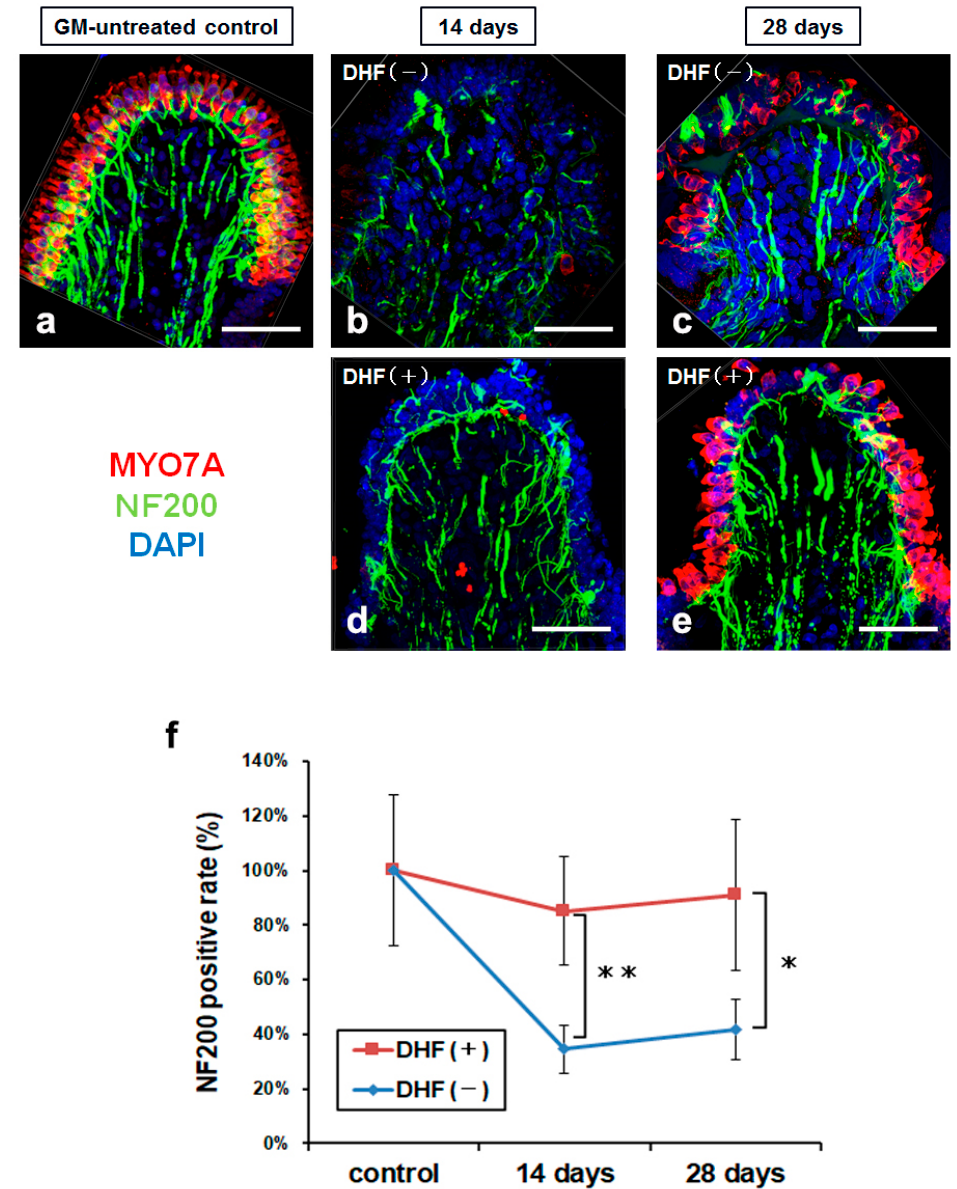
Figure 4. Protection of nerve fiber. ( a – e ) Three-dimensional images of the crista ampullaris stained with MYO7A antibody (red), NF200 antibody (green), and DAPI (blue). ( a ) GM-untreated control. ( b , c ) The cristae without DHF at 14 and 28 days after GM injection. ( d , e ) The cristae with DHF at 14 and 28 days after GM injection. The ampullary nerves of the DHF (+) group are better preserved than those of the DHF ( − ) group at 14 days and 28 days after GM treatment. ( f ) NF200 positive rates are significantly higher in the DHF (+) group than in DHF ( − ) group at both 14 and 28 days after GM treatment. N = 5 each for control, DHF (+) and DHF ( − ) groups at 14 and 28 days. Scale bar ( a – e ), 50 µm; DAPI, 4 ′ , 6-diamino-2-phenylindole; DHF, 7, 8–Dihydroxyflavone; GM, gentamicin; MYO7A, myosin 7a; NF200, neurofilament 200; ** p < 0.01; * p < 0.05 (Mann-Whitney U test).